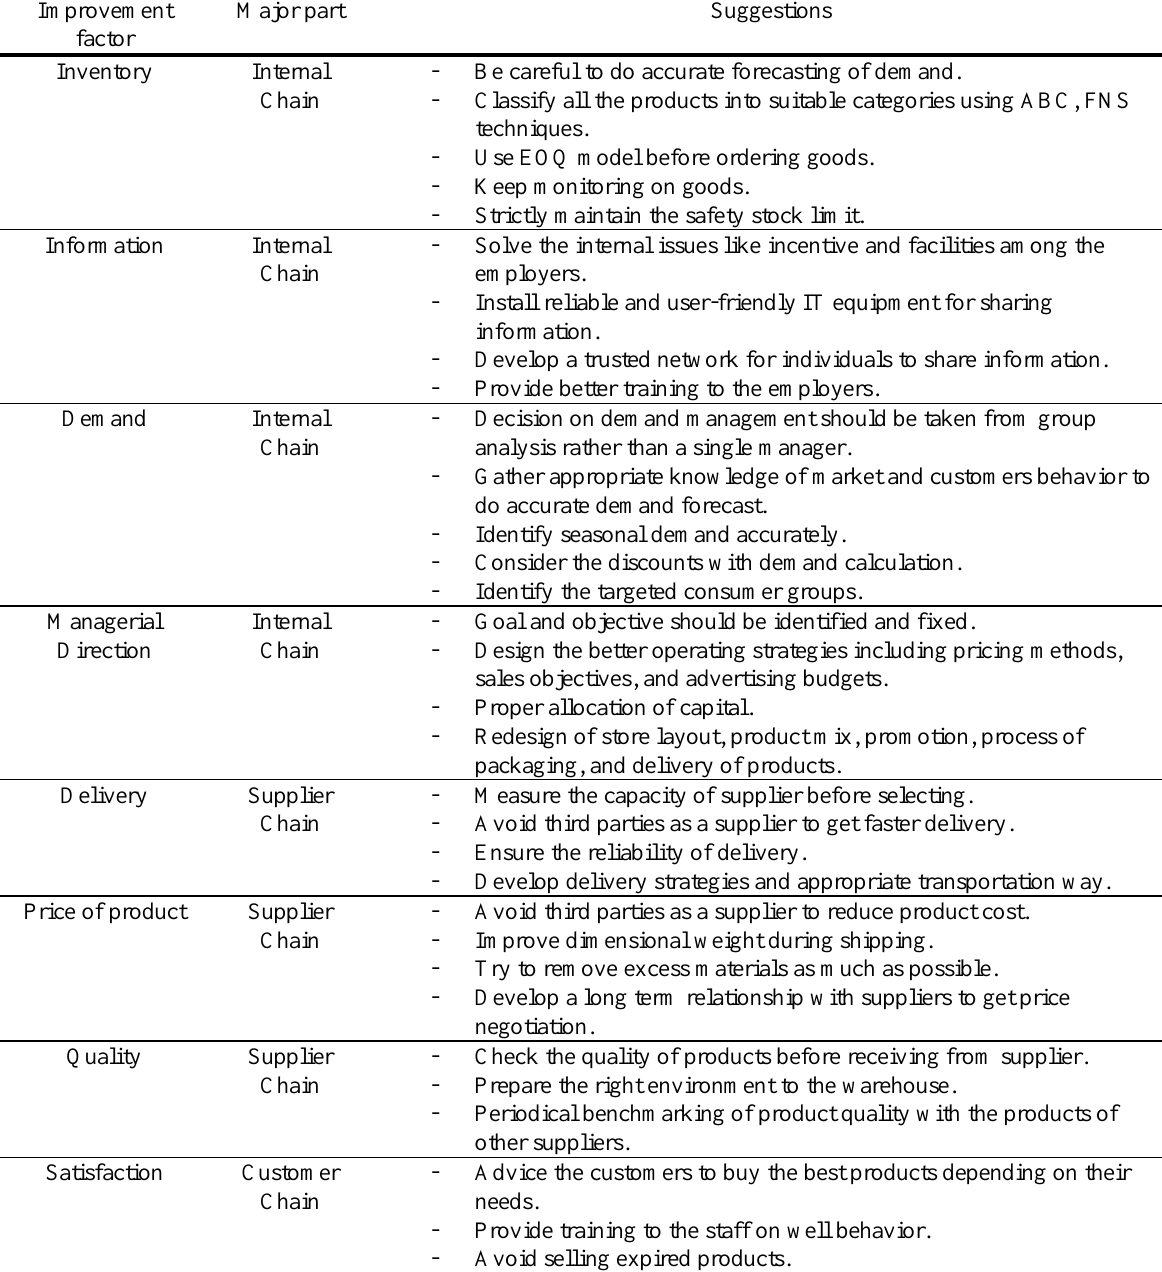
Table 16. Suggestions for major eight